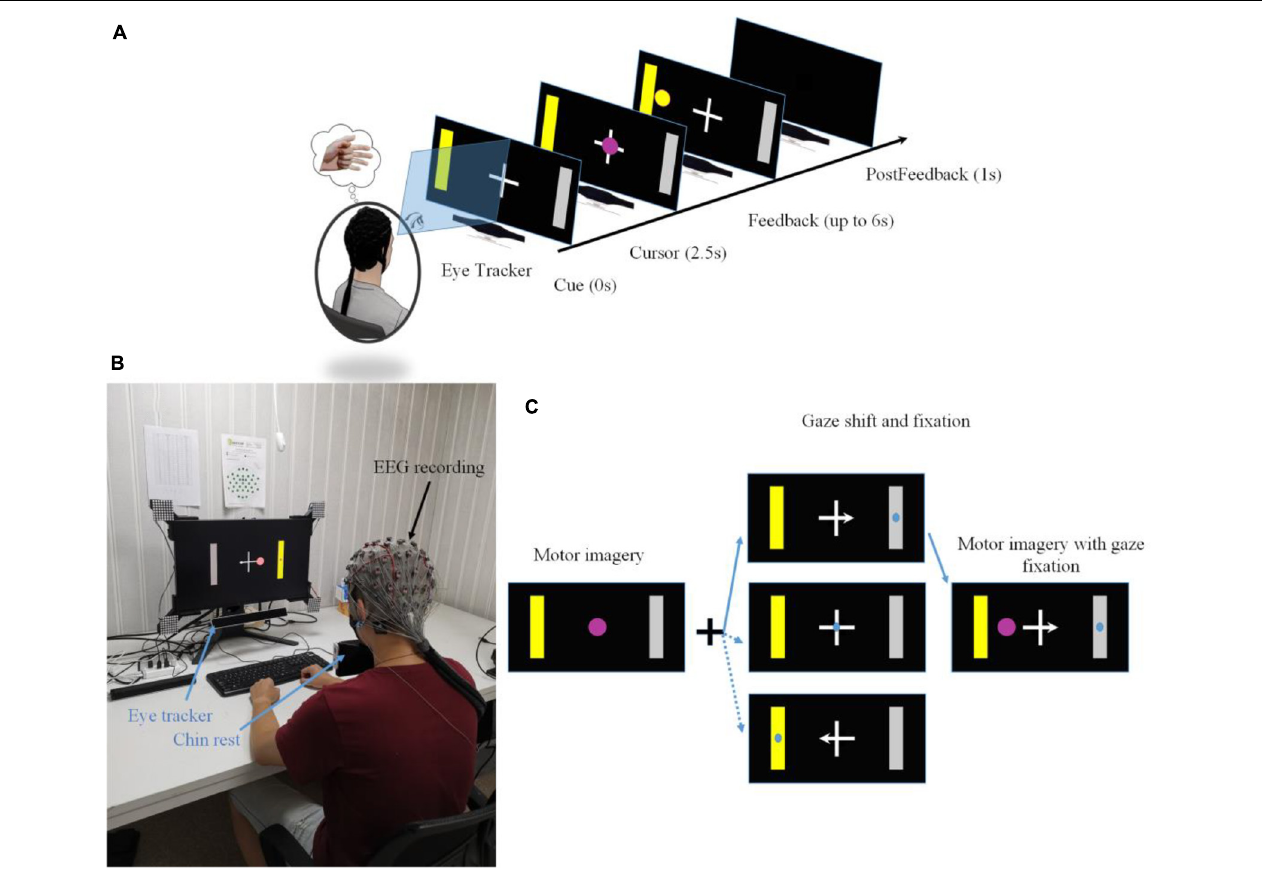
FIGURE 1 | (A) A single trial structure of a motor imagery based BCI with gaze shift and fixation. (B) The experimental setup of motor imagery based BCI with eye tracking. A chin rest was used to secure the position of a subject’s head. (C) Three control conditions resulting from the congruence between a motor imagery task and a gaze shift and fixation